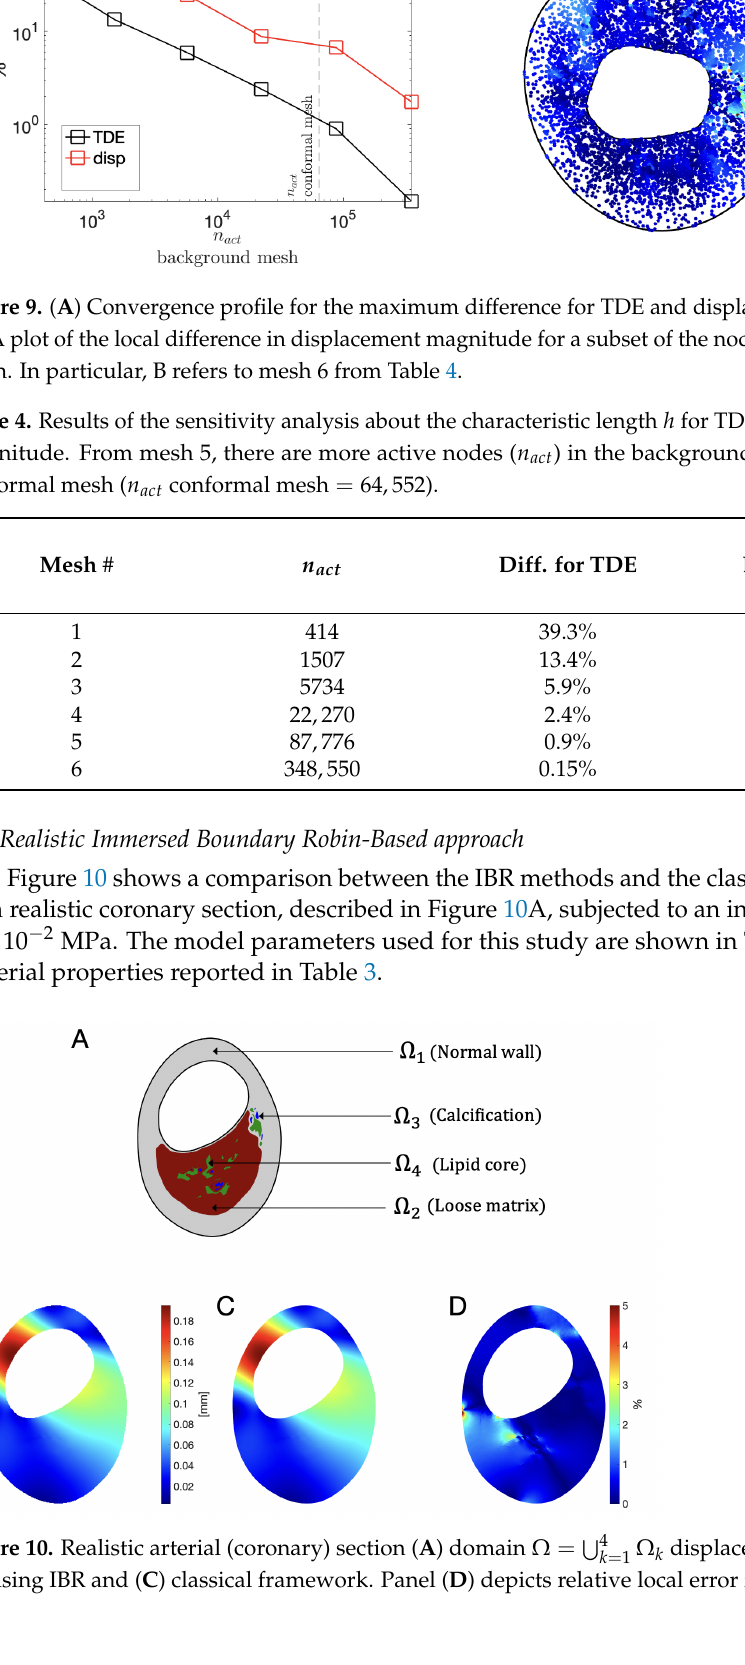
Figure 10. Realistic arterial (coronary) section ( A ) domain Ω = (cid:83) 4 ( B ) using IBR and ( C ) classical framework. Panel ( D ) depicts relative local error for